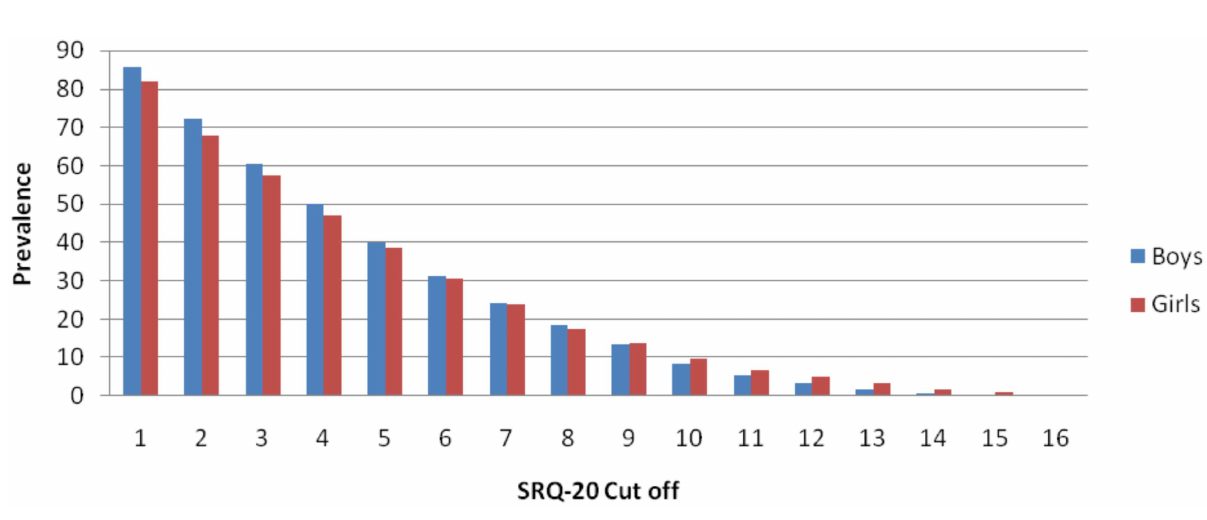
Fig 2. Prevalence of SRQ-20 Using Different Cut-Points by Gender, JLFSY